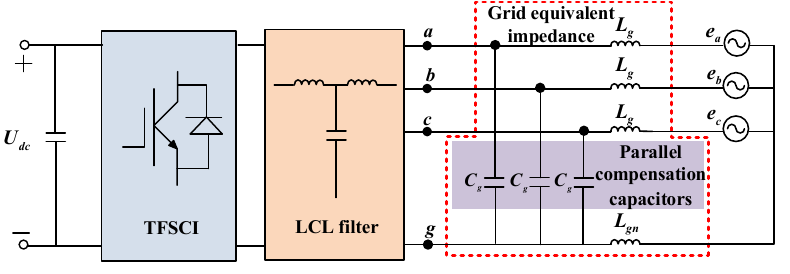
Figure 5. Circuit model of LCL-TFSCI connected to the grid with parallel compensation capacitors. According to the circuit theory, the positive-sequence, negative-sequence, and zero-